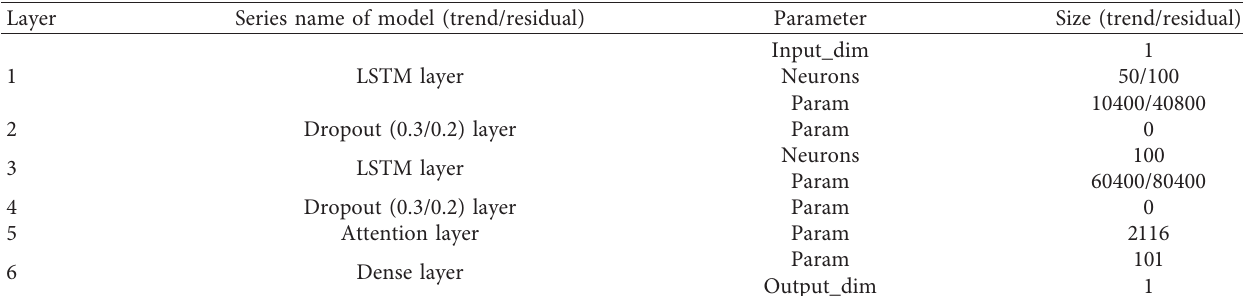
Figure 12: Performance of loss function in different depth models. Table 3: Structure and parameter of trend series and residual series of prediction models.